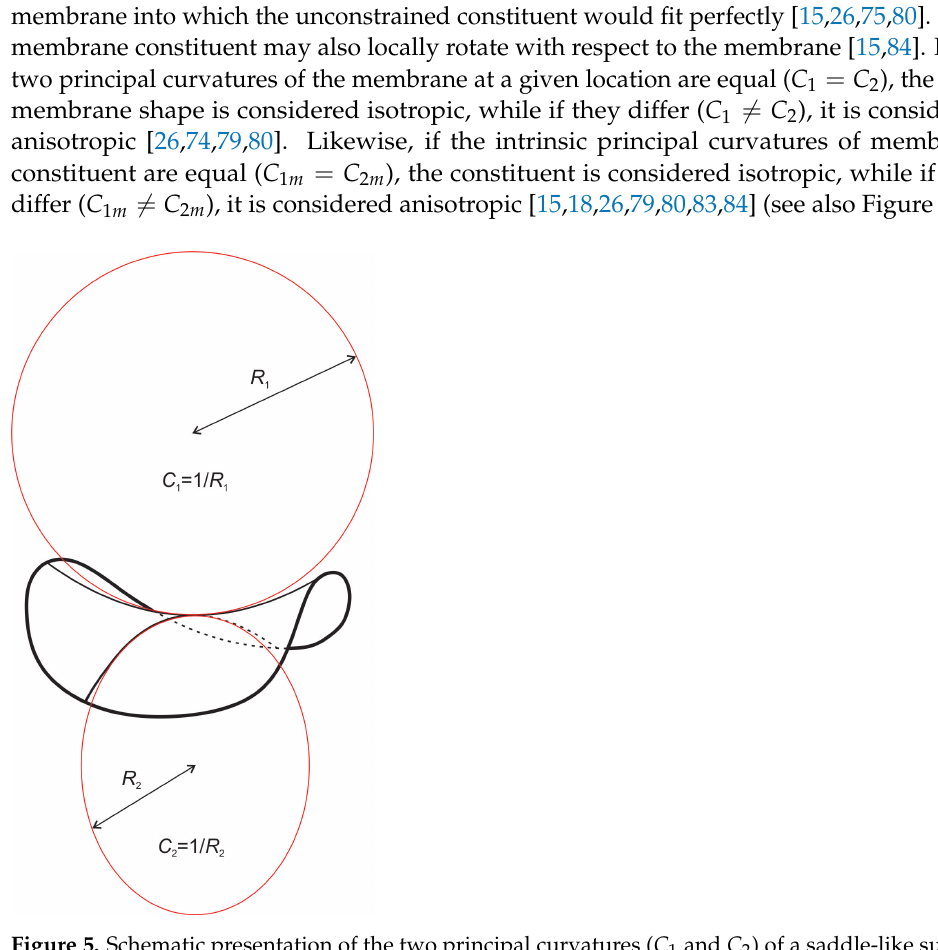
Figure 5. Schematic presentation of the two principal curvatures ( C 1 and C 2 ) of a saddle-like